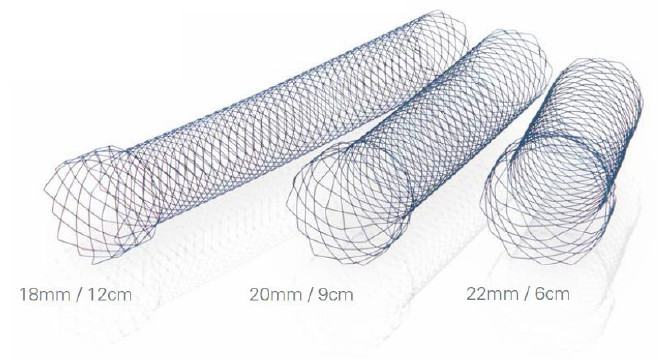
Figure 1. WallFlex™ Duodenal